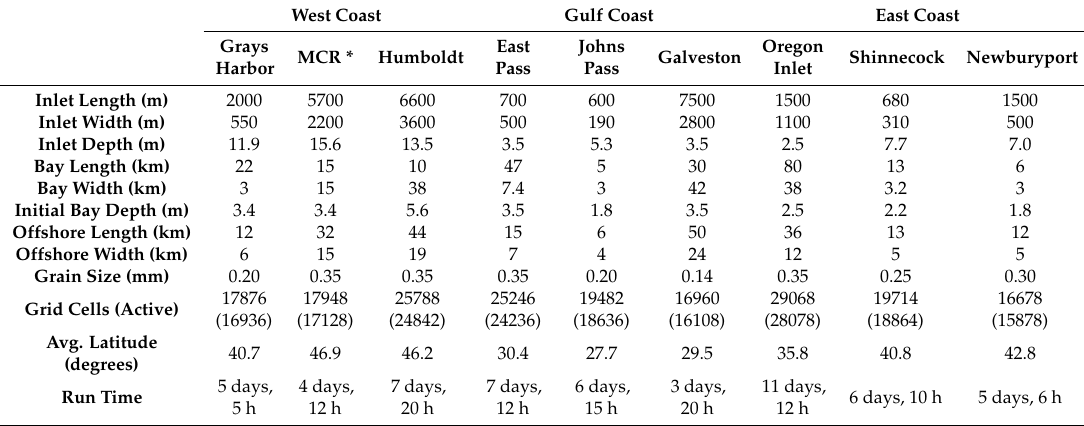
Table 1. Geometric characteristics and selected model parameter settings for the 9 simulated inlets.